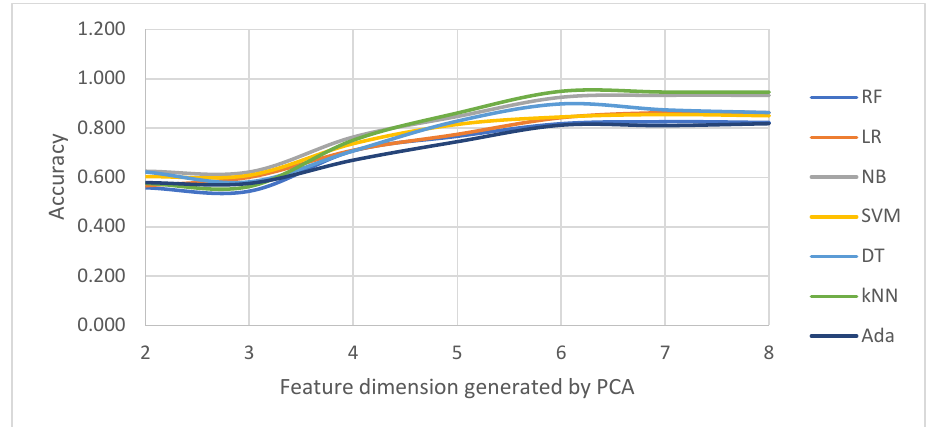
Fig. 11. Accuracy results for the comparison between different machine learning models using PCA